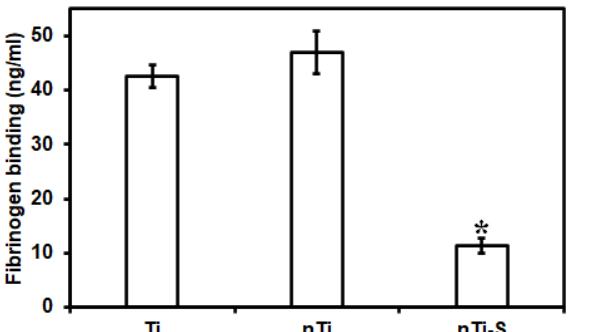
Figure 2. Fibrinogen adsorption from PRP on different surfaces measured using a microplate reader. (* p < 0.05; n min = 9.)